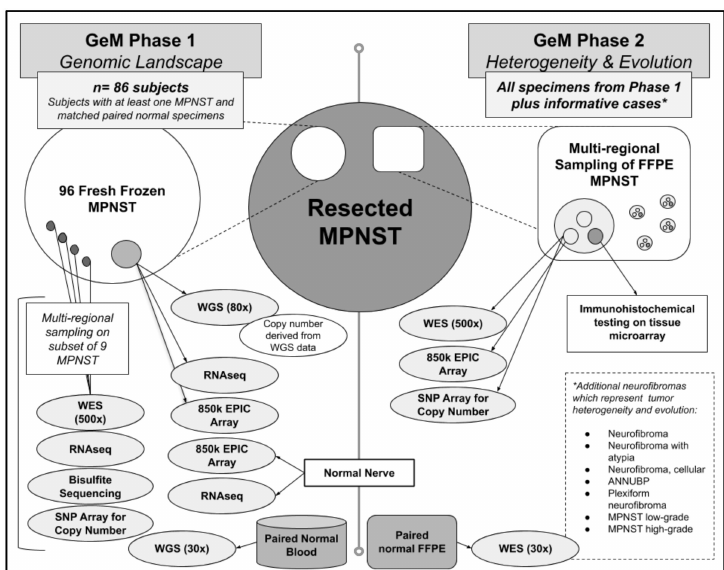
Figure 1. The GeM(Genomics of MPNST) Consortium will conduct multi-omic analyses on both fresh frozen and para ffi n-embedded tissue samples of resected MPNSTs(Malignant Peripheral Nerve Sheath Tumors) and related neurofibroma, and normal